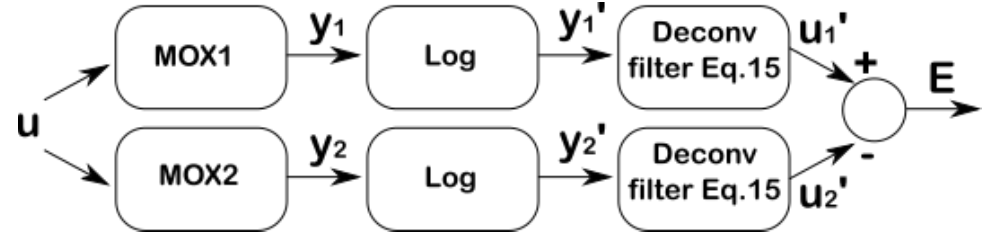
Figure 9. Blind deconvolution with two MOX sensors. The deconvolved outputs 𝑢 1′ and 𝑢 2′ should be similar as both sensors are excited by the same input 𝑢 . The original input can be reconstructed as (𝑒 𝑢 1′ + 𝑒 𝑢 2′ )/2 .